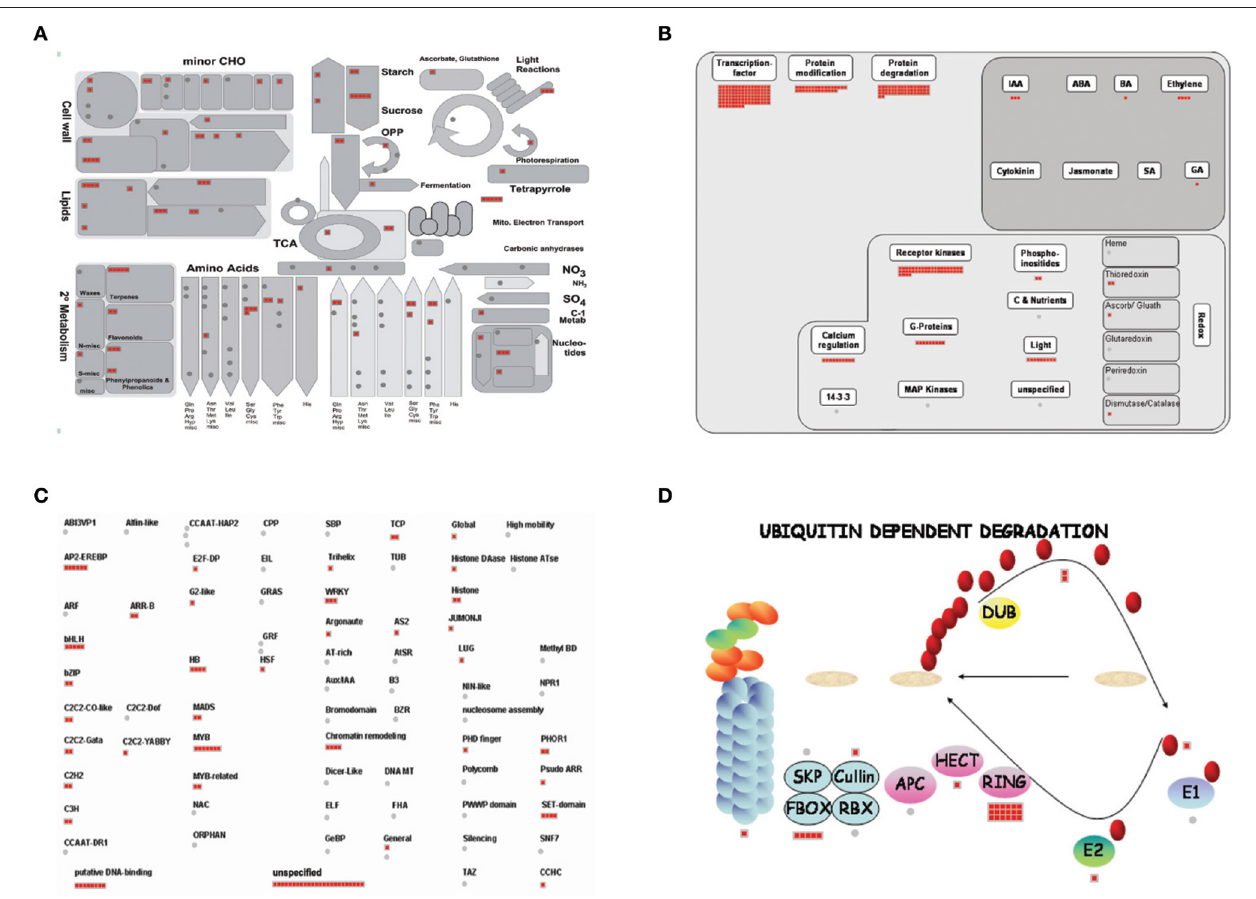
FIGURE 6 | MapMan analysis of genes associated with response to water deficiency. Overviews: (A) Metabolism, (B) Regulation, (C) Transcription, and (D) Proteasome. Red boxes indicate genes up-regulated by stress. Detailed information is presented in Tables S6 , S7